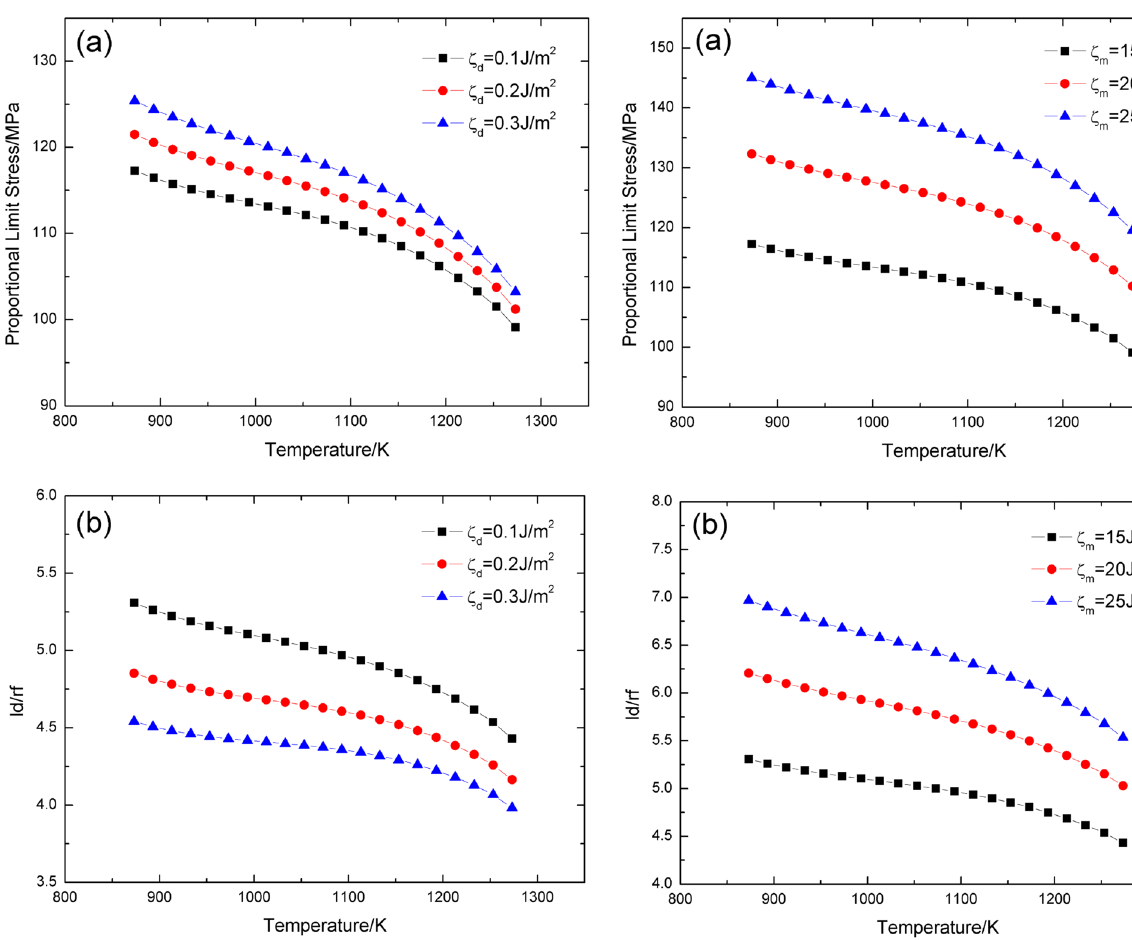
Figure 4: E ff ect of the interface debonding energy on ( a ) the PLS versus temperature curves; ( b ) the fi ber/matrix interface debonding length versus temperature curves of SiC/SiC composite.